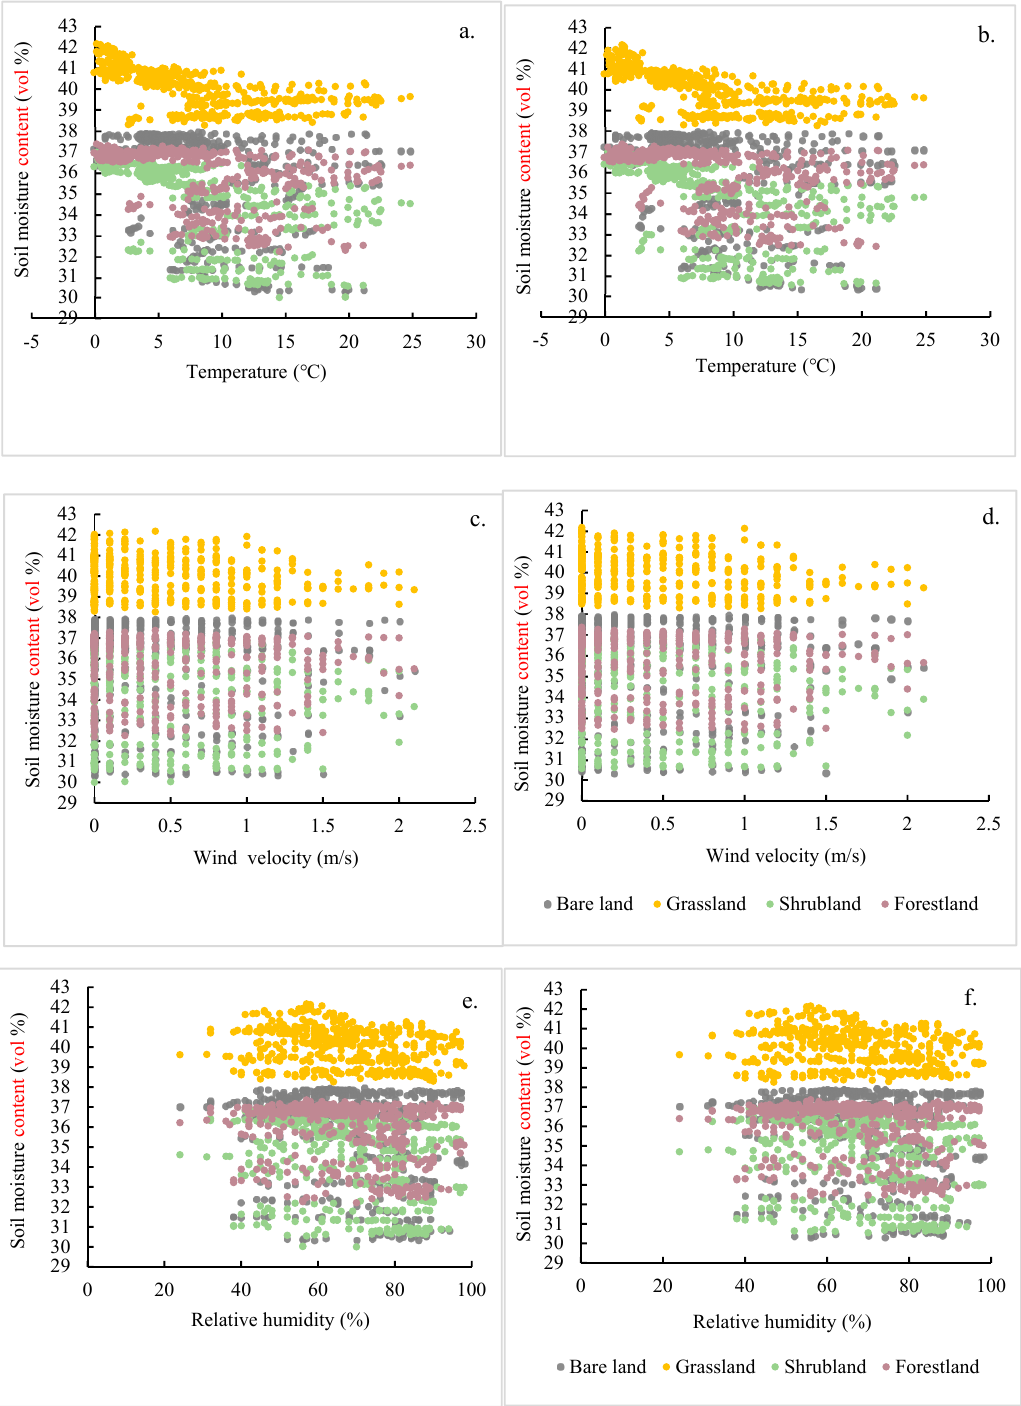
Figure 13. Volumetric soil moisture content, with meteorological factors in a continuous period without rainfall in the dry season with 1 h for hysteresis of temperature ( a ), 5 h for hysteresis of temperature ( b ), 1 h for hysteresis of wind velocity ( c ), 5 h for hysteresis of wind velocity ( d ), 1 h for hysteresis of relative humidity ( e ), and 5 h for hysteresis of relative humidity ( f ).